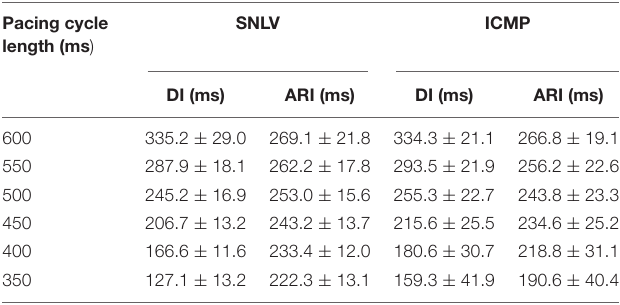
TABLE 2 | Activation recovery interval and diastolic interval during different pacing cycle lengths in patients with ICMP and SNLV. Pacing cycle length (ms )